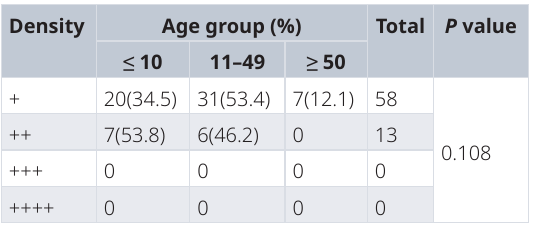
Table 4. Correlation between parasitemia and